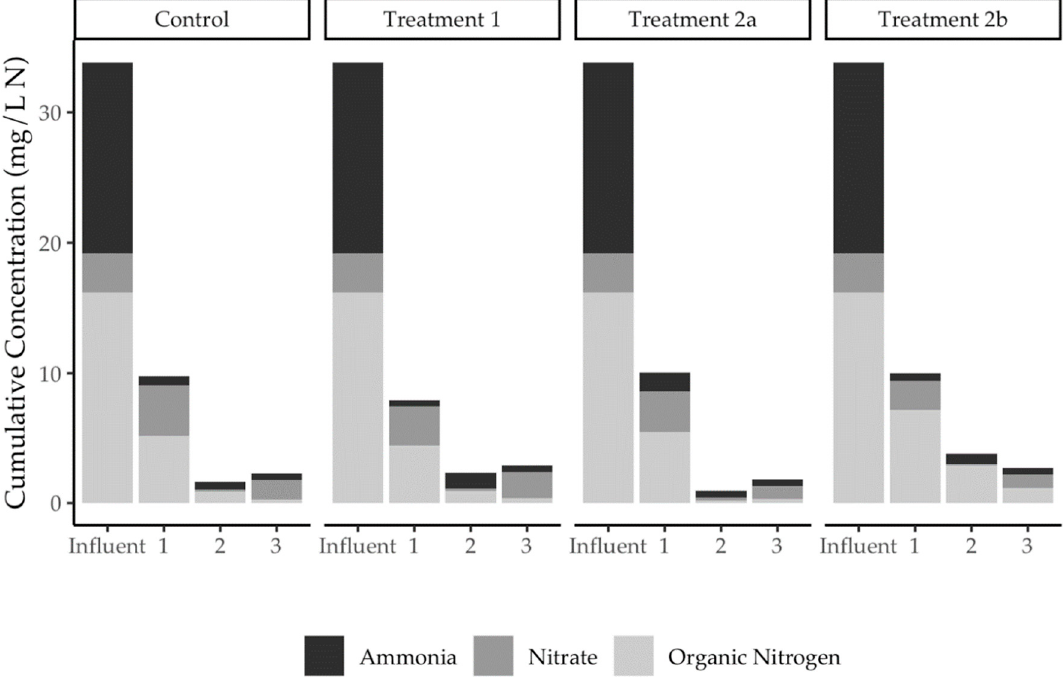
Figure 5. Total nitrogen removals and nitrogen transformations in the treatment systems.